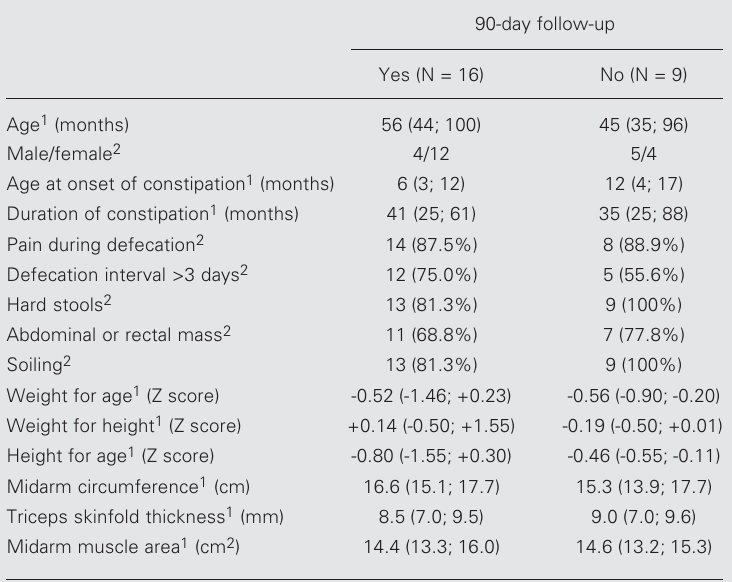
Table 1. Clinical features and anthropometric data at admission of patients who completed or did not complete the